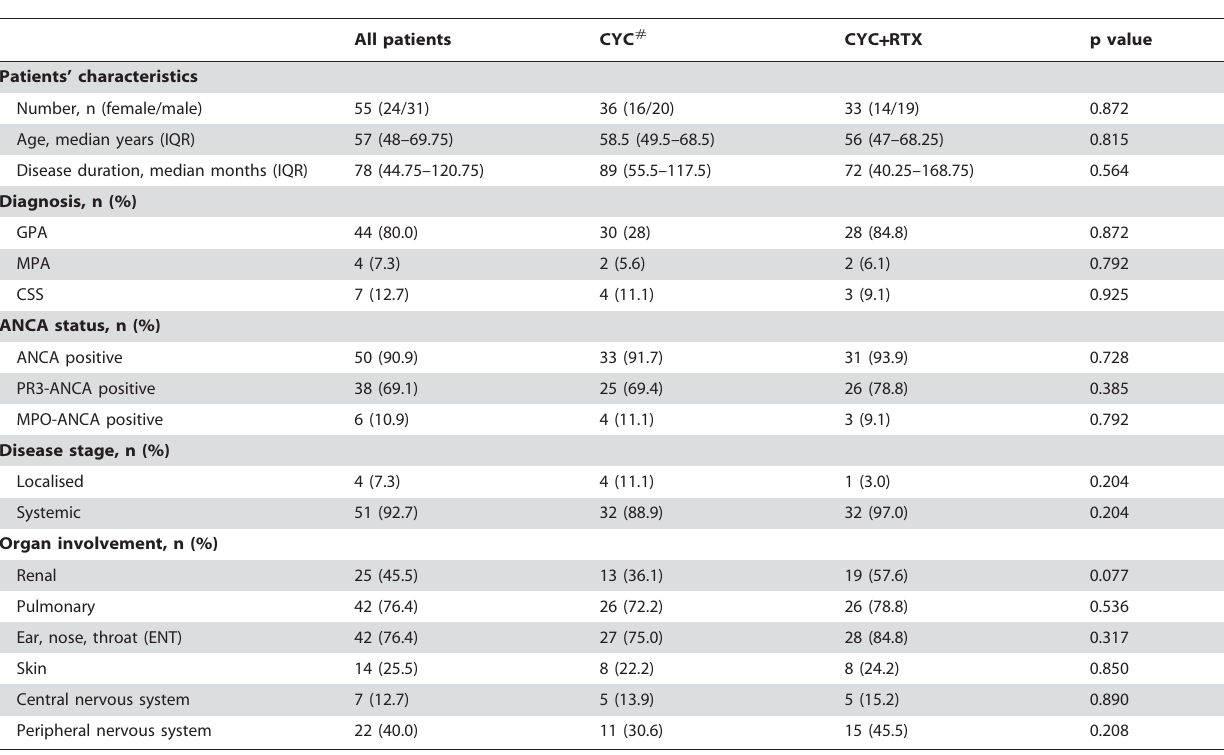
Table 1. Patients’ characteristics of the AAV